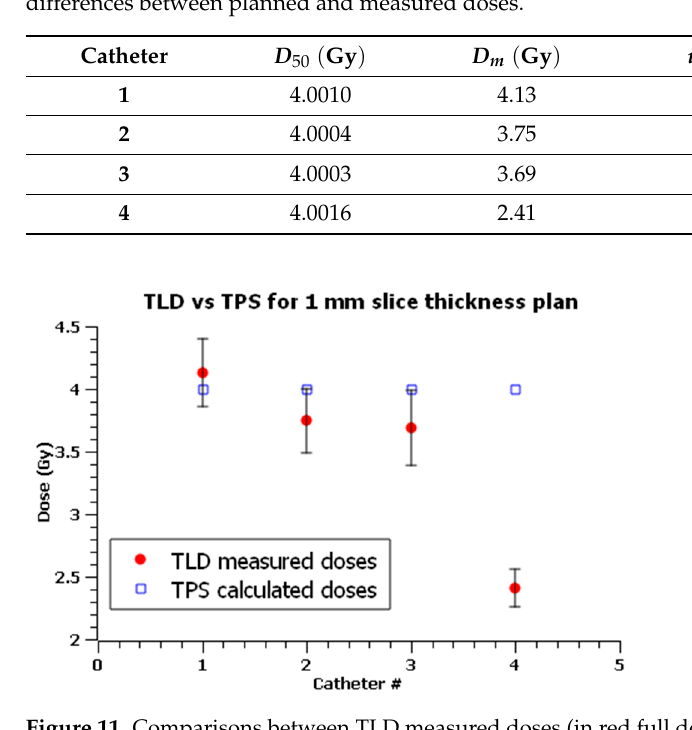
Figure 11. Comparisons between TLD measured doses (in red full dots) and TPS calculated doses (in blue empty squares) for the 1 mm slice thickness plan. x axis is the catheter number (#) corresponding to the point of measurement. Error bars show the estimated expanded (k = 2) uncertainty for TLD measurements.